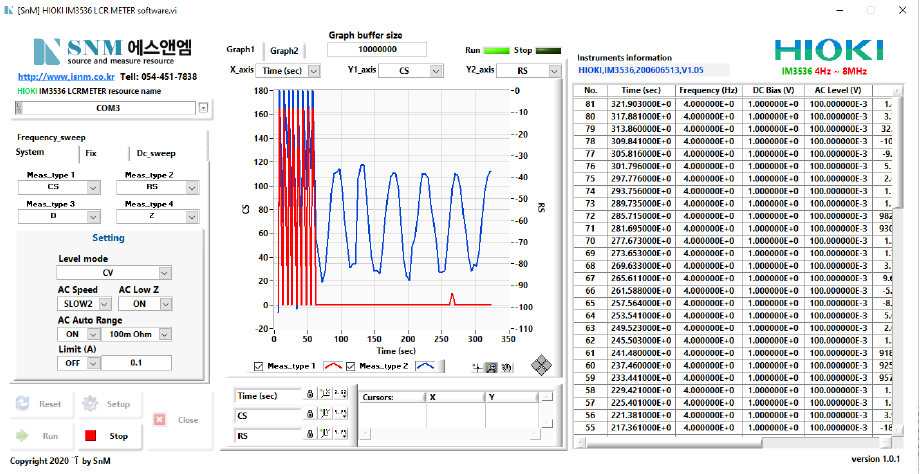
Figure 6. A system view of the LCR Meter computer aided